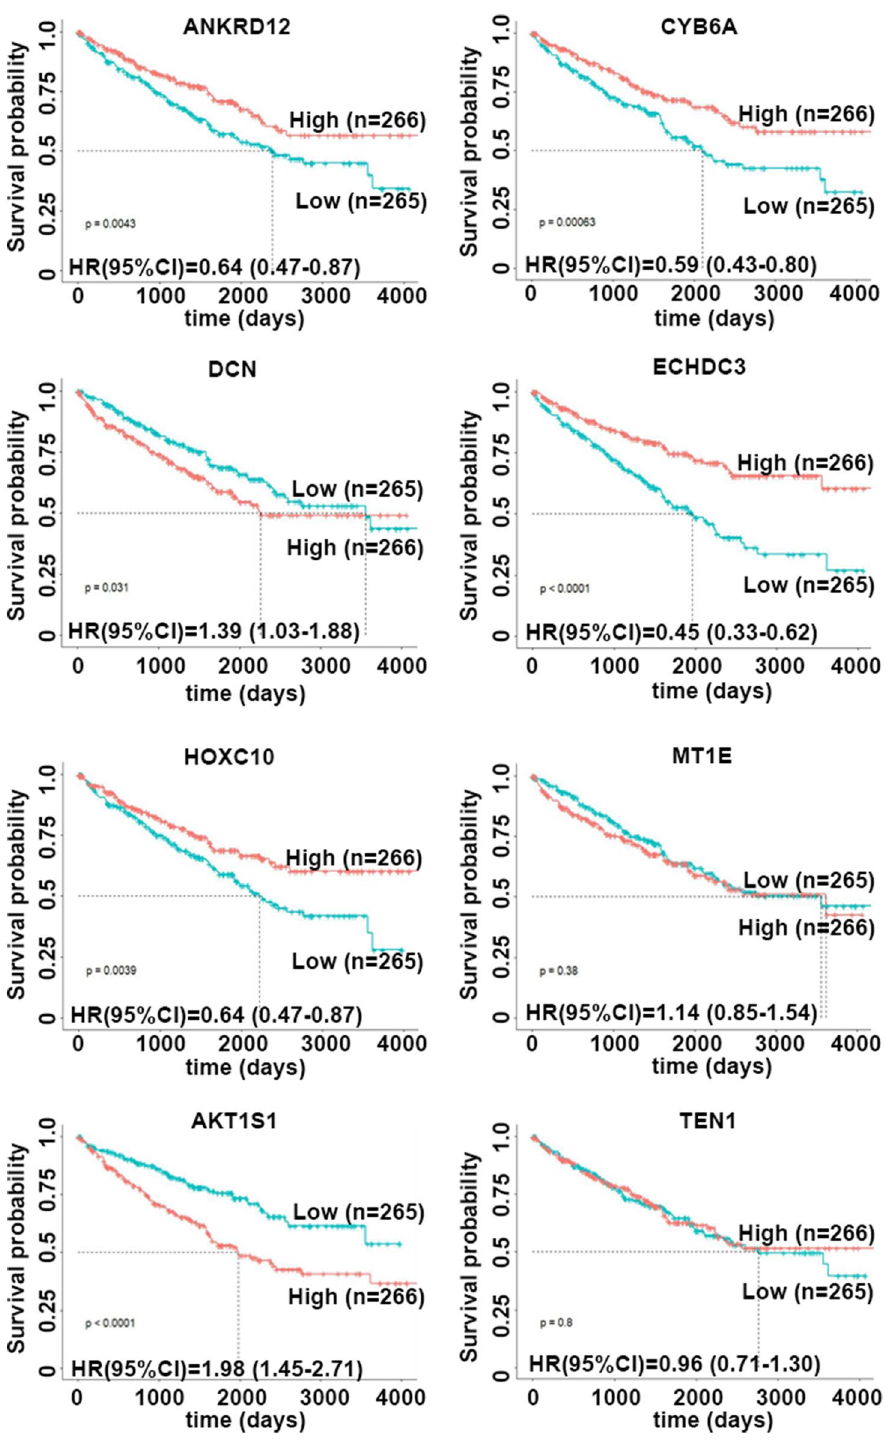
Figure 4. Prognostic Value of Individual Cigarette Smoke Exposure-related Gene In TCGA-KIRC Cohort. The Kaplan–Meier curves showed that the overall survival of patients with high or low expression (ANKRD12, CYB5A, DCN, ECHDC3, HOXC10, MT1E, AKT1S1, TEN1) based on defined cutoff (< or ≥ median of gene expression in cancer tissues) in TCGA-KIRC